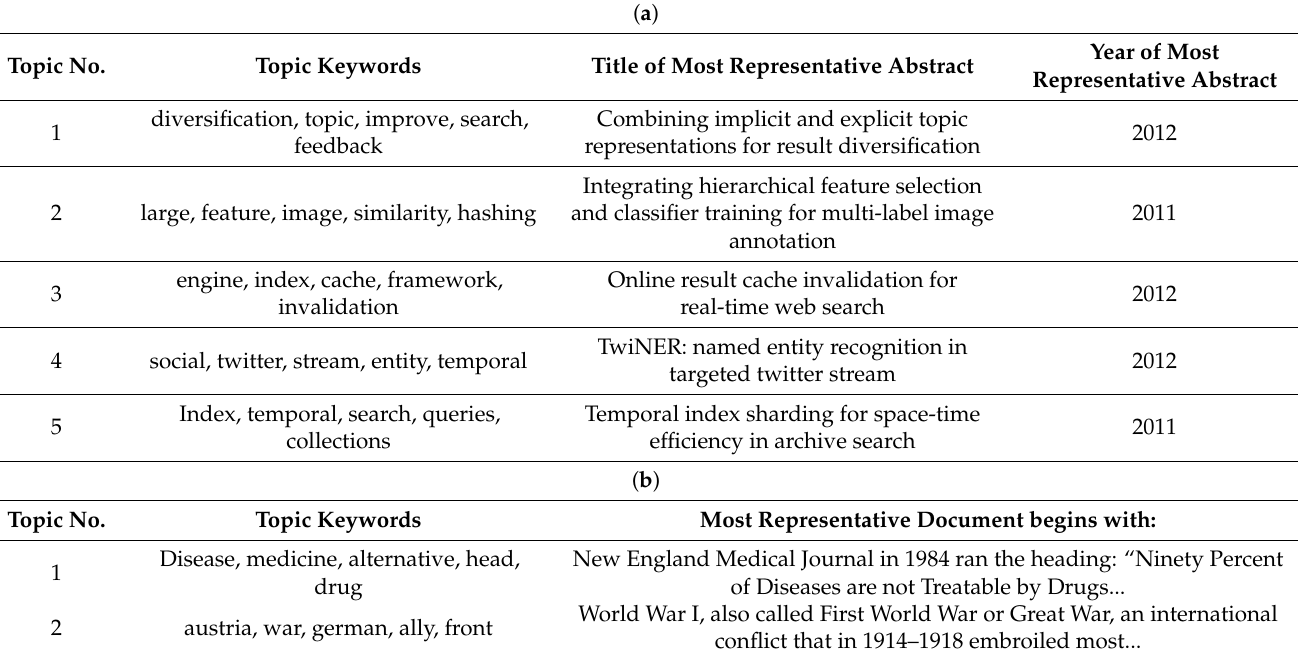
Table 9. Framework #1 emerging topics for (a) SIGIR and (b) 10 Newsgroups